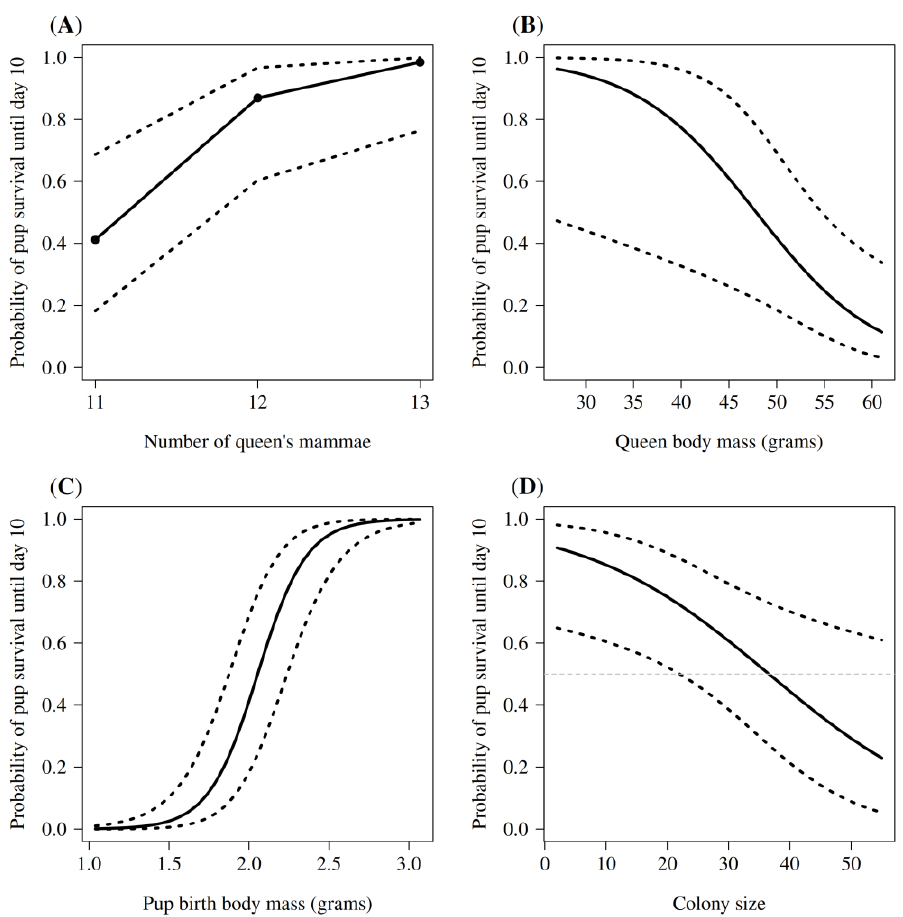
Figure 3. Predictions (black line) and 95.0% confidence intervals (black dashed lines) displaying the probability for naked mole-rat pups to have lived for longer than 10 days, i.e., to survive from birth (day 0) to day 9, as a function of: ( A ) maternal number of mammae, ( B ) body mass of queens at conception, ( C ) pup birth body mass and ( D ) colony size (i.e., number of all colony members) with the grey dashed line representing a 50.0% probability of survival on pup survival.